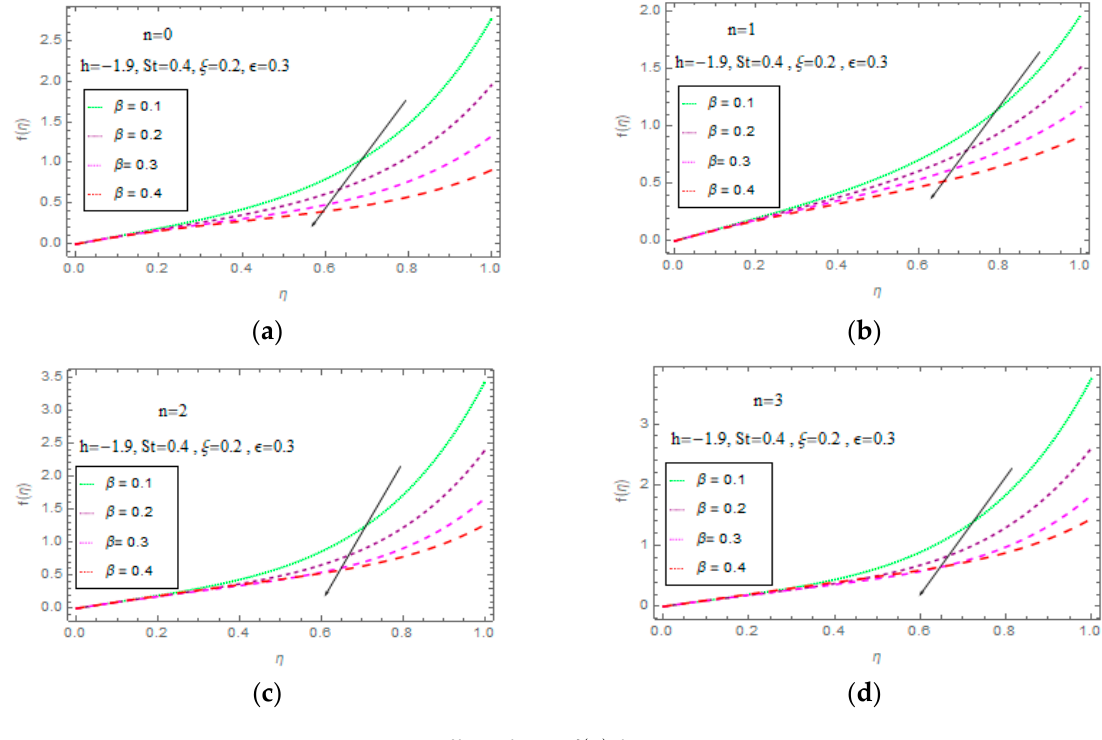
Figure 5. Effect of 𝛽 on 𝑓(𝜂) for 𝑛 = 0,1,2,3 .